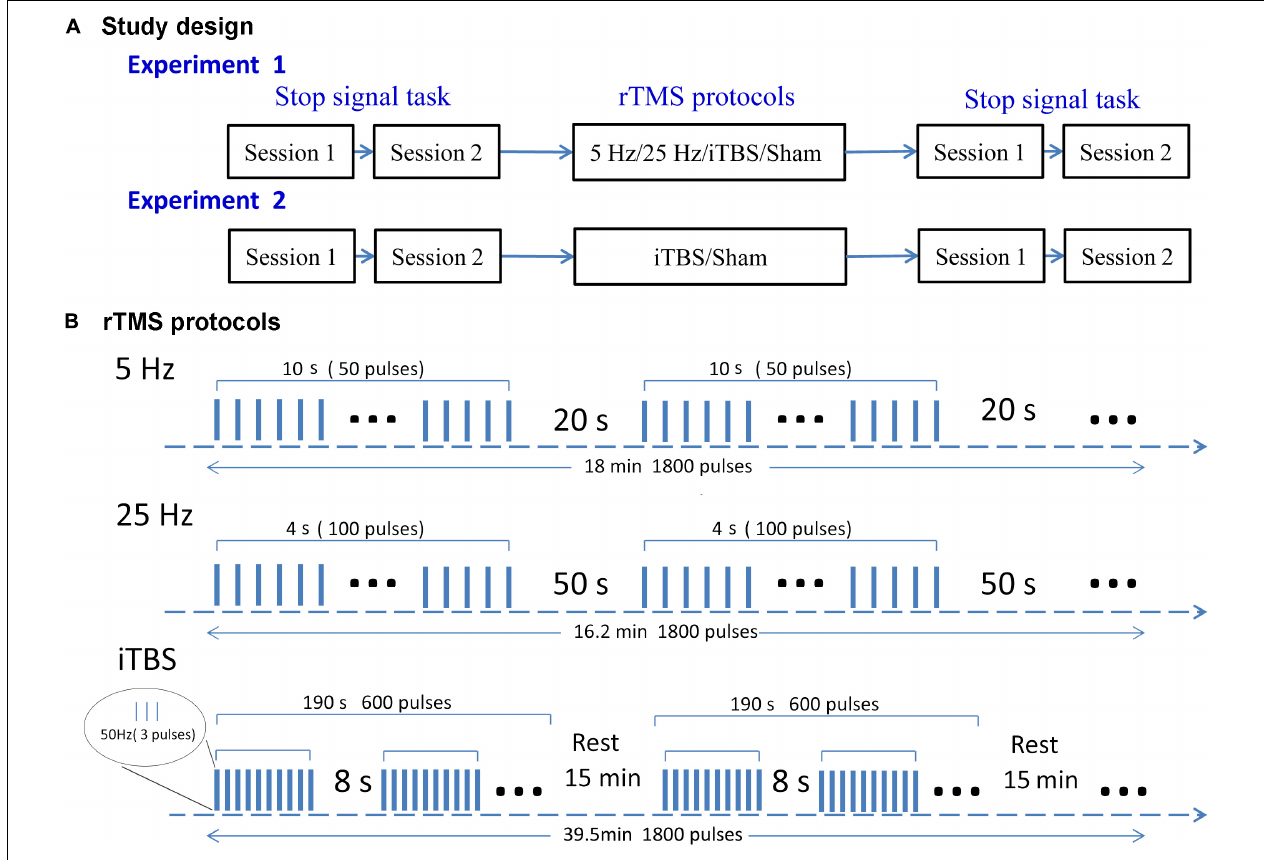
FIGURE 1 | Study design (A) and rTMS protocols (B) . In experiment 1, each subject received four rTMS protocols on four separate days. Experiment 2 was performed after the end of experiment 1, with subjects receiving iTBS or sham rTMS on two separate days. Both experiments followed a within-subject design. The rTMS protocols were delivered in a randomized order for each subject. Subjects were required to perform the SST twice before and after stimulation. Each rTMS protocol contained 1800 pulses. This takes 18, 16.2, and 39.5 min in the 5-Hz, 25-Hz, and iTBS protocols,